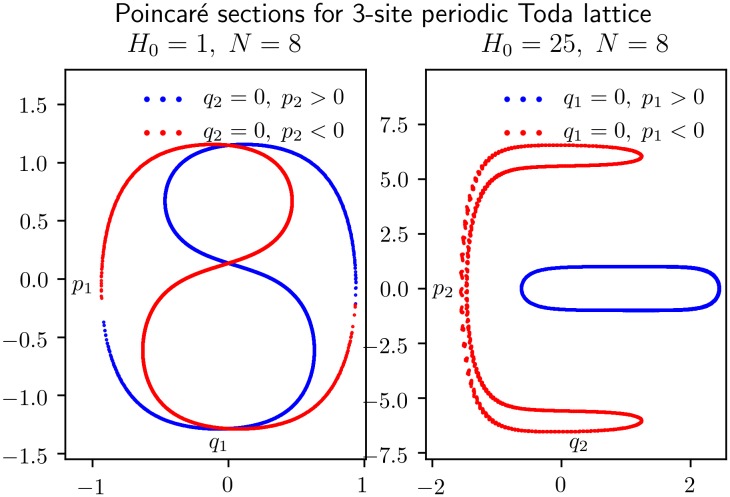
Poincaré sections for an orbit of the reduced 3-site Toda lattice model of Eq (11).The left panel shows 4 000 crossings of the (q2 = 0)-plane, 2 000 in the positive direction (p2 > 0, marked blue) and 2 000 in the negative direction (p2 < 0, marked red). The right panel similarly shows 4 000 crossings of the (q1 = 0)-plane. The dynamics between each crossing is determined by a KiMoKi solver of order 8, with timestep τ = 0.05. The initial condition is z0 = (0.1, 0, 0.1, 1.40709), with H0 = 1, C3⊥ = −6.45412, for the left panel, and z0 = (0, 1, 6.92943, 1), with H0 = 25, C3⊥ = 2597.68431, for the right panel.